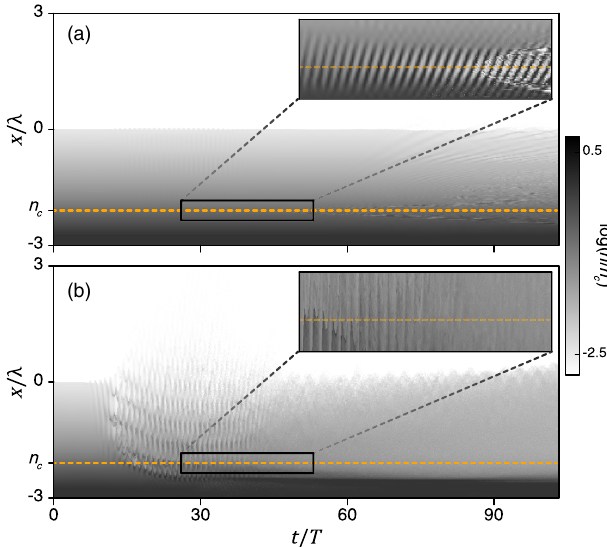
FIG. 10. 2D PIC simulations in the long-gradient regime for two different laser amplitudes. In both cases, the gradient scale length is L ¼ λ = 1 . 5 (long-gradient regime) and θ i ¼ 55 °. The gray scale represents the temporal evolution n e ð x; t Þ of the plasma electron density profile along the direction x normal to the plasma surface for (a) a 0 ¼ 0 . 1 and (b) a 0 ¼ 3 . 5 . The insets represent enlargements centered around the critical electron density of the initial plasma profile n e ð x; t ¼ 0 Þ ¼ n c (shown by the orange dashed